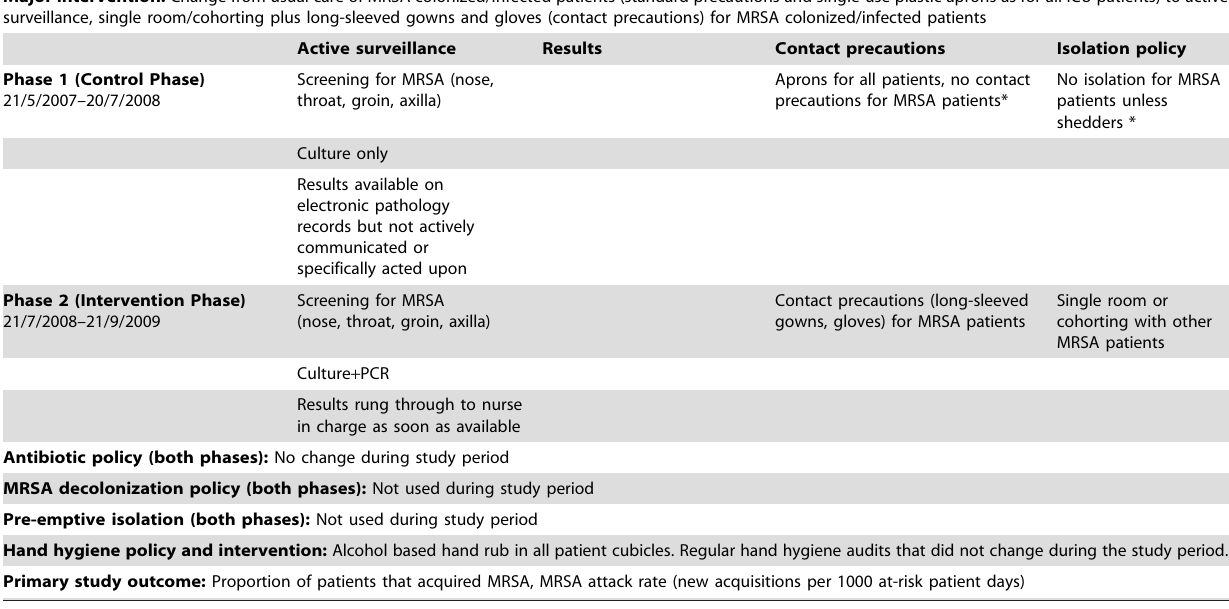
Population characteristics: Unselected consecutive ICU admissions. Endemic